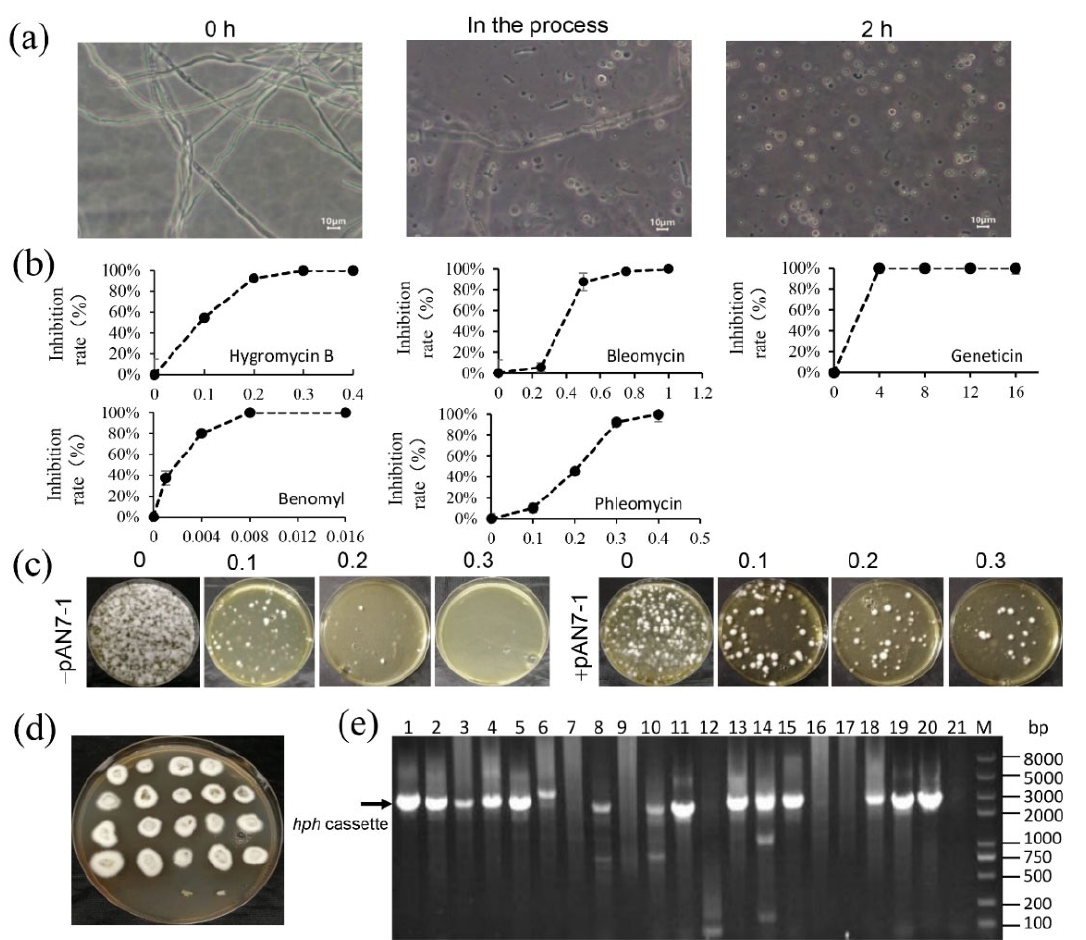
Figure 2. Establishment of the protoplast-mediated transformation system for C. paspali . ( a ) Pro- toplast formation at different time of enzymatic hydrolysis. The bar is 10 µ m. ( b ) Determination of minimal inhibitory concentrations (MICs) of 5 antibiotics. The concentrations of antibiotics are measured in mg · mL − 1 . ( c ) Protoplast regeneration on the regeneration plates with different con- centrations of hygromycin B. − pAN7-1: protoplasts transformed with mock plasmid (negative control). +pAN7-1: protoplasts transformed with dominant pAN7-1 harboring hph gene. The layered medium culture method was used and the upper layer medium (5 mL) contained 0, 0.1, 0.2, and 0.3 mg · mL − 1 hygromycin B, respectively. ( d ) Growth of the transformants on fresh PGA